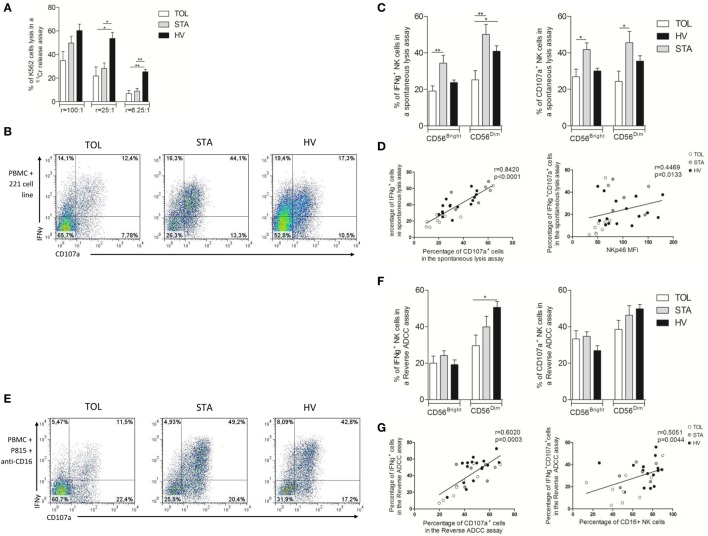
(A) Mean percentage with SEM of K562 lysis based on 51Cr release. Peripheral blood mononuclear cells (PBMCs) from tolerant patient (TOL), stable patient (STA), or healthy volunteer (HV) were cocultured with K562, and 51Cr release by K562 following lysis by PBMCs was evaluated. Three different PBMC:K562 ratios were analyzed: 100:1, 25:1, and 6.25:1. TOL (n = 7) are represented by white bars, STA (n = 9) by gray bars, and HV (n = 8) by black bars. (Median and range are given in Table S2 in Supplementary Material.) (B) Representative dot plots illustrating CD107a membranous expression and IFNγ production by CD56Dim NK cells from one representative TOL, STA, and HV in a spontaneous lysis functional assay. (C) Mean percentage with SEM of IFNγ+ NK cells and the mean percentage with SEM of CD107a+ NK cells among CD56Bright or CD56Dim NK cells from TOL (white bars) (n = 9), STA (gray bars) (n = 7), and HV (black bars) (n = 15) following 5 h of coculture with 221 cell lines. (D) Correlation analysis between the percentage of IFNγ+ NK cells and the percentage of CD107a+ NK cells in the spontaneous lysis assay and correlation between the percentage of IFNγ+CD107a+ NK cells and the level of NKp46 (MFI) (r = Spearman correlation coefficient) (TOL = white dot, STA = gray dot, and HV = black dot). (Median and range are given in Table S2 in Supplementary Material.) (E) Representative dot plots illustrating CD107a membranous expression and IFNγ production by CD56Dim NK cells from one representative TOL, STA, and HV in a reverse antibody-dependent cellular cytotoxicity (ADCC) assay. (Median and range are given in Table S2 in Supplementary Material.). (F) Mean percentage with SEM of IFNγ+ NK cells and the mean percentage with SEM of CD107a+ NK cells among CD56Bright or CD56Dim NK cells from TOL (white bars) (n = 9), STA (gray bars) (n = 7), and HV (black bars) (n = 15) following 5 h of coculture with P815 cell lines and anti-CD16. (G) Correlation analysis between the percentage of IFNγ+ NK cells and the percentage of CD107a+ NK cells in the reverse ADCC assay and correlation between the percentage of IFNγ+CD107a+ NK cells and the percentage of CD16+ NK cells (r = Spearman correlation coefficient) (TOL = white dot, STA = gray dot, and HV = black dot). Significance was defined as *p < 0.05, **p < 0.01, ***p < 0.001, and ****p < 0.0001.